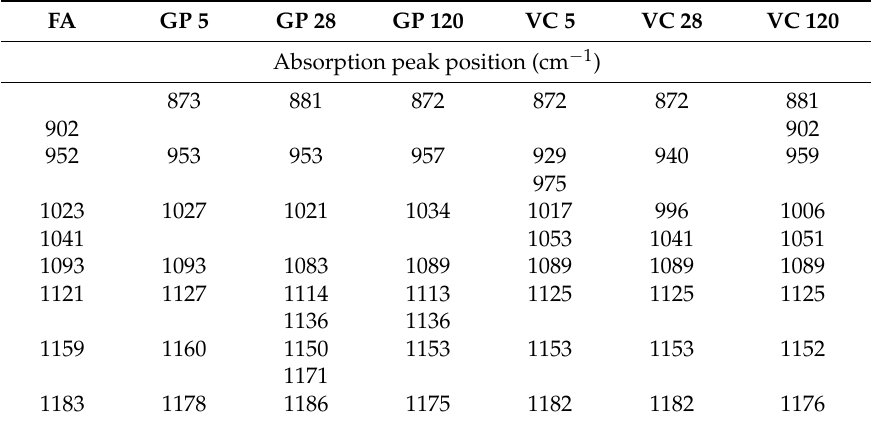
Table 3. Absorption peak values of the deconvoluted FTIR